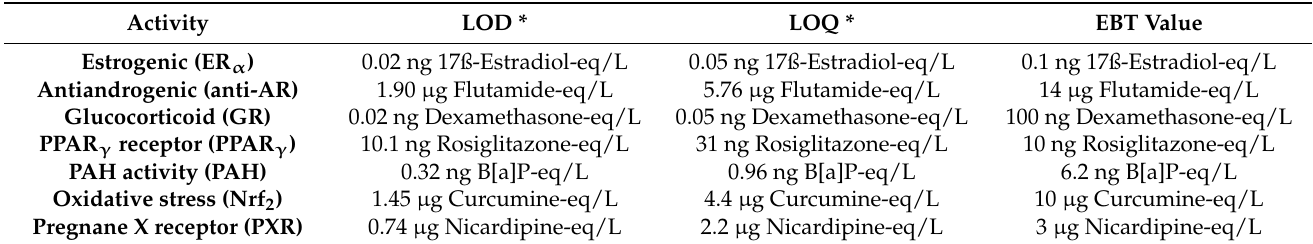
Table 1. Performance indicator bioassays and their effect-based trigger values (EBTs).